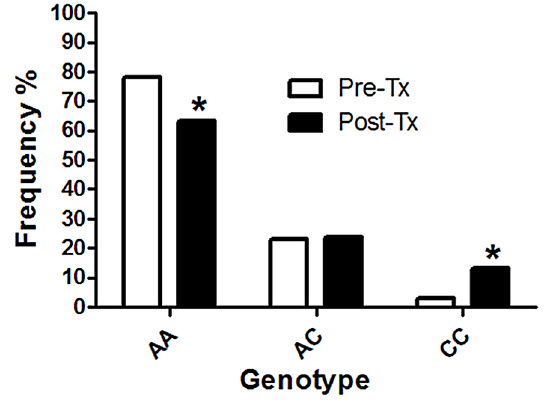
Figure 3. Genotype frequencies of the b -tubulin gene position 198 in T.trichiura from Haiti before and after ABZ treatment. Genotype frequencies of T. trichura collected in Haiti. The number of individual T. trichiura eggs genotyped, according to the available material, was 65 in the untreated group (pre-Tx) and 38 in the treated group (post-Tx). Sequences were diploid, AA indicates the homozygous susceptible-type GAA/GAA, AC the heterozygous GAA/GCA and CC, the homozygous resistance-type GCA/GCA; Tx=treatment, *Indicates a significant difference (p , 0.001) in genotype frequency between the pre- and post treatment groups. P-values were obtained by Fisher’s exact test.